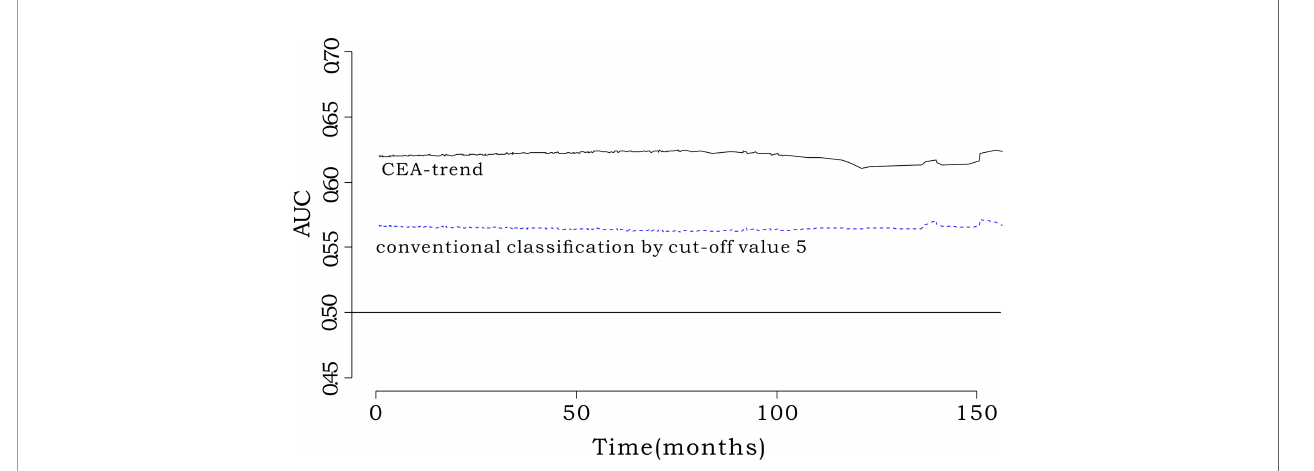
FIGURE 4 | Comparison of iAUC between CEA-trend and conventional classi fi cation by cut-off value 5. The integrated AUC value of CEA-trend (0.619; 95% con fi dence interval [CI], 0.553-0.668) was higher than that of the conventional classi fi cation by cut-off value 5 (0.570, 95% CI: 0.514-0.634) (bootstrap iAUC mean difference=0.048, 95% CI=0.002-0.085). “ conventional classi fi cation by cut-off value 5 ” composed of strati fi cation by the cut-off value 5 such as “ Group 1: preoperative CEA<5, Group 2: preoperative CEA ≥ 5 & postoperative CEA<5, and Group 3: preoperative CEA ≥ 5 & postoperative CEA ≥ 5 ”